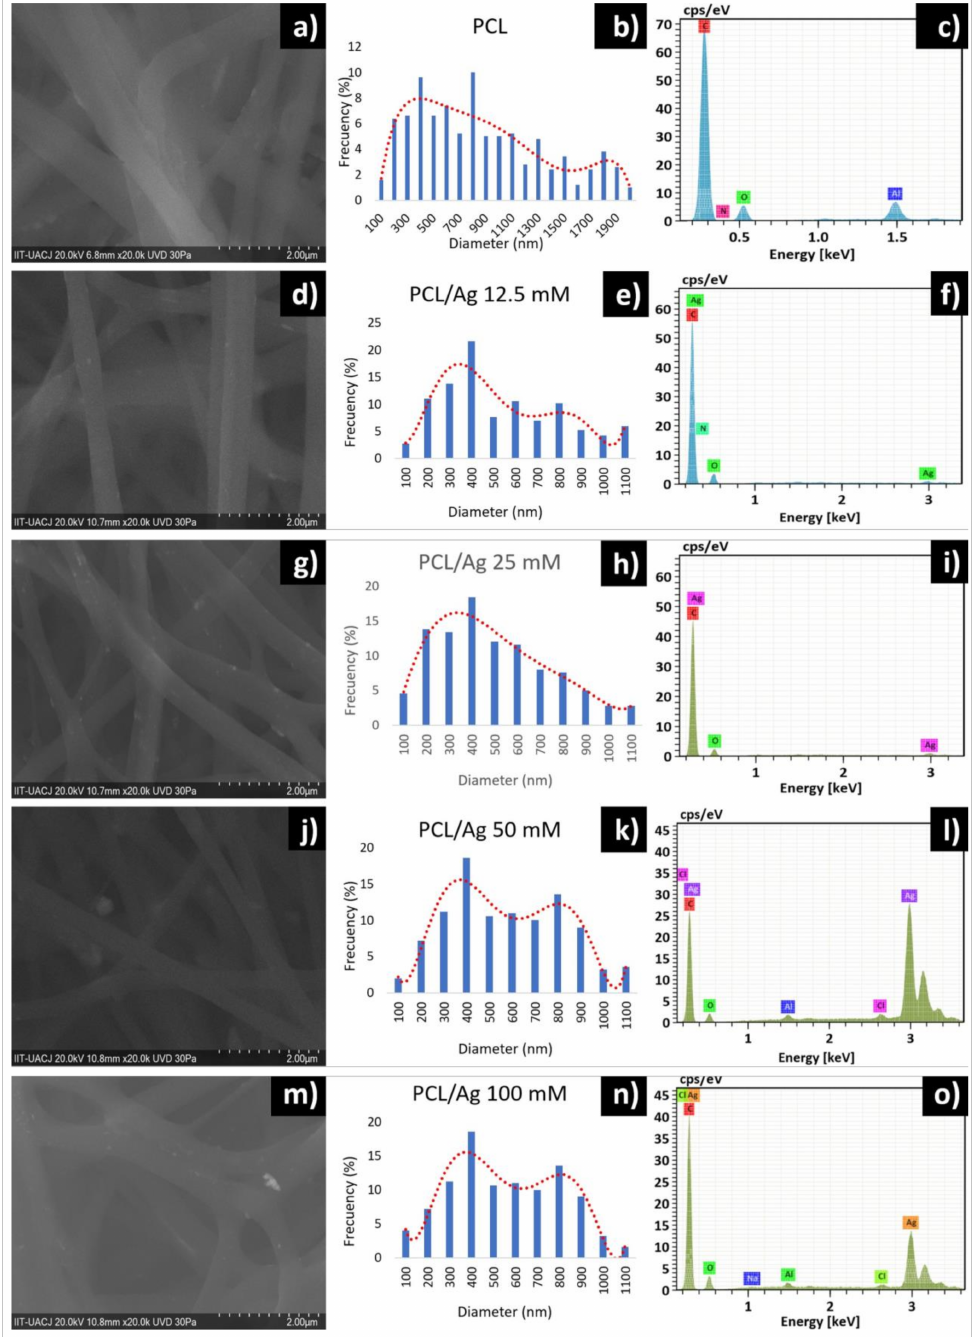
Figure 3. Micrographs obtained by SEM of the nanofibers: ( a ) PCL, ( b ) PCL frequency distribution, ( c ) PCL EDX spectrum, ( d ) PCL/Ag 12.5 mM, ( e ) PCL/Ag 12.5 mM frequency distribution, ( f ) PCL/Ag 12.5 mM EDX spectrum, ( g ) PCL/Ag 25 mM, ( h ) PCL/Ag 25 mM frequency distribution, ( i ) PCL/Ag 25 mM EDX spectrum, ( j ) PCL/Ag 50 mM, ( k ) PCL/Ag 50 mM frequency distribution, ( l ) PCL/Ag 50 mM EDX spectrum, ( m ) PCL/Ag 100 mM, ( n ) PCL/Ag 100 mM frequency distribution, and ( o ) PCL/Ag 100 mM EDX